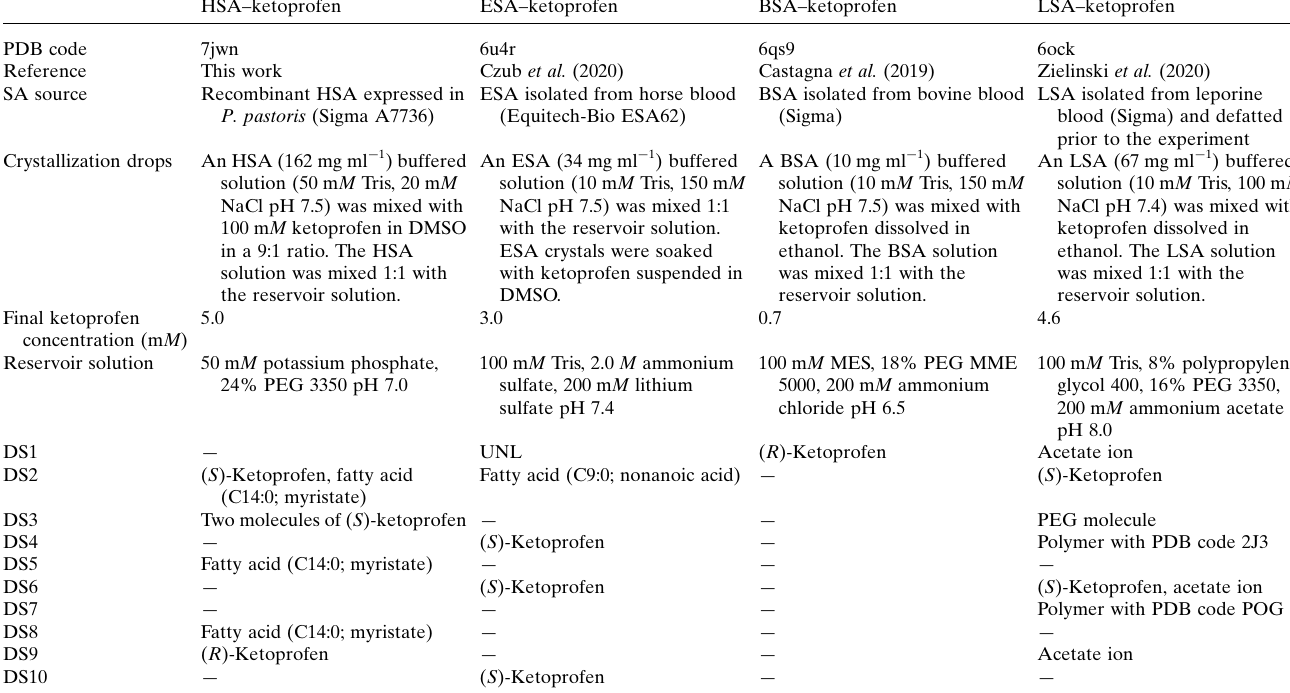
Table 3 Conditions used for crystallization of SA–ketoprofen complexes and the ligands observed in the common drug-binding